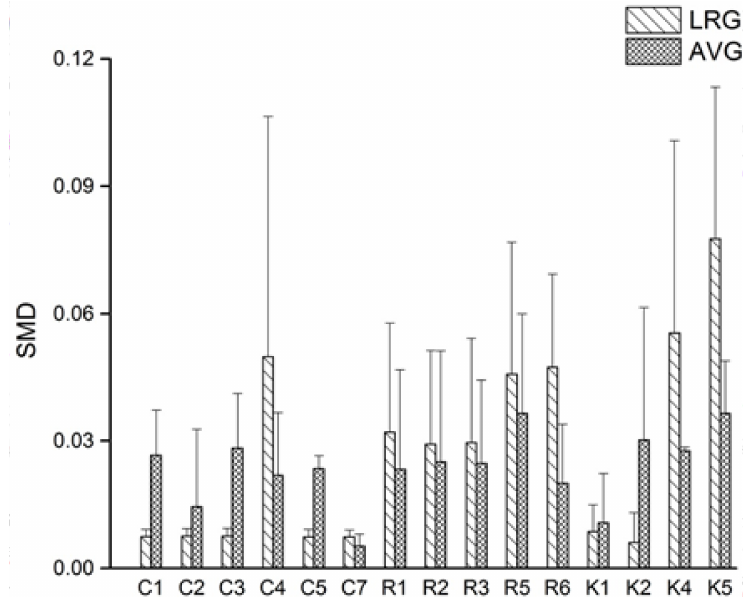
Figure 3. Standard method difference (SMD) of the LRG and AVG